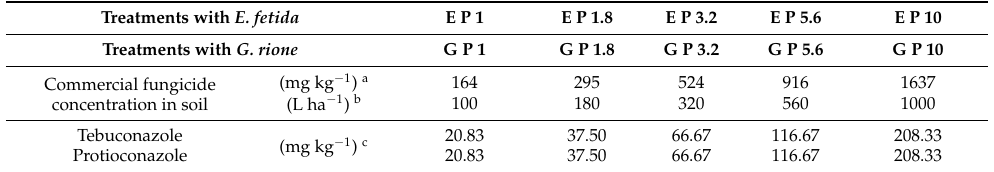
Table 2. Test substance concentration for treatments with PROSARO ® (P) and the earthworm species E. fetida (E) or G. rione (G) in Toxicity test